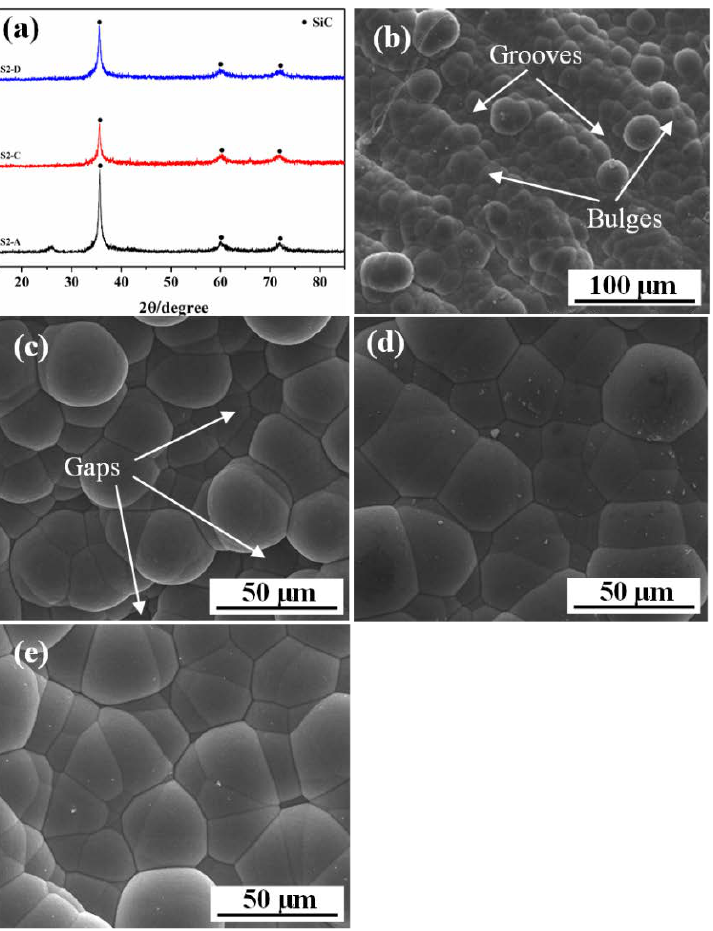
Figure 5. XRD patterns ( a ) and surface images of the SiC layer. ( b ) S2-A; ( c ) S2-B; ( d ) S2-C; ( e ) S2-D.